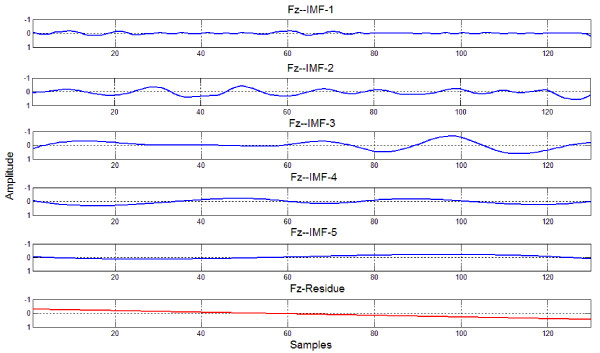
IMFs of the trace in Figure 2.